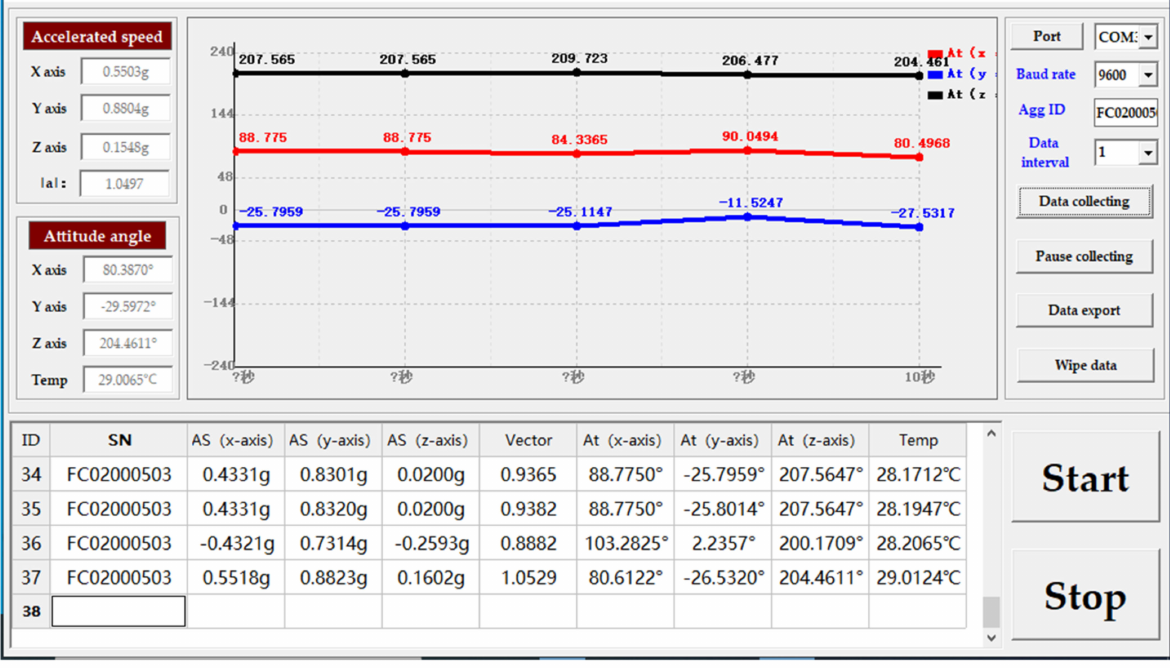
Figure 4. Analysis software of RDAPS (The unit in x-axis is second).